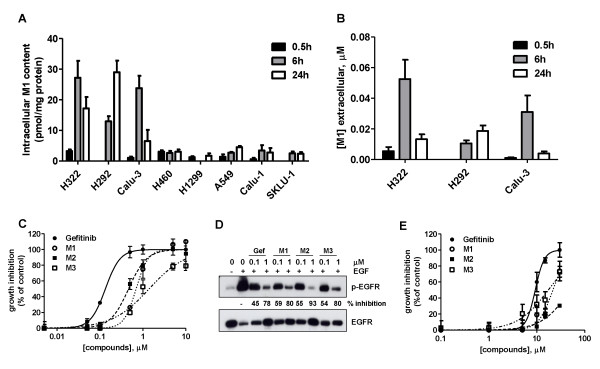
Production and biological activity of gefitinib metabolites. Cells were incubated with 0.1 μM gefitinib for 0.5, 6 or 24 h and then the M1 content was determined both in the intracellular (A) and extracellular (B) compartment, through LC-MS/MS analysis. M1 levels calculated for each cell line were expressed as pmol/mg of protein (intracellular) or μM (extracellular). Values given are the means (± SD) of three independent determinations C) H322 cells were exposed for 72 h to different concentrations of gefitinib or its metabolites (ranging from 0.05 to 10 μM) and then cell growth was assessed using crystal violet staining. Data are expressed as percent inhibition of cell proliferation versus control cells. The mean values of three independent measurements (± SD) are shown. D) H322 cells were incubated for 0.5 h with the indicated concentrations of gefitinib and metabolites, before stimulation with 0.1 μg/ml EGF for 5 min. Western blot analysis was performed by using monoclonal antibodies directed to p-EGFR(p-Tyr1068) and to EGFR. The immunoreactive spots at each point were quantified by densitometric analysis, ratios of phosphotyrosine/total EGFR were calculated and values expressed as percentage of inhibition versus control. The experiment, repeated three times, yielded similar results. E) H1299 cells were exposed for 72 h to different concentrations of gefitinib or its metabolites (ranging from 1 to 30 μM) and then cell growth was assessed using crystal violet staining. Data are expressed as percent inhibition of cell proliferation versus control cells. The mean values of three independent measurements (± SD) are shown.